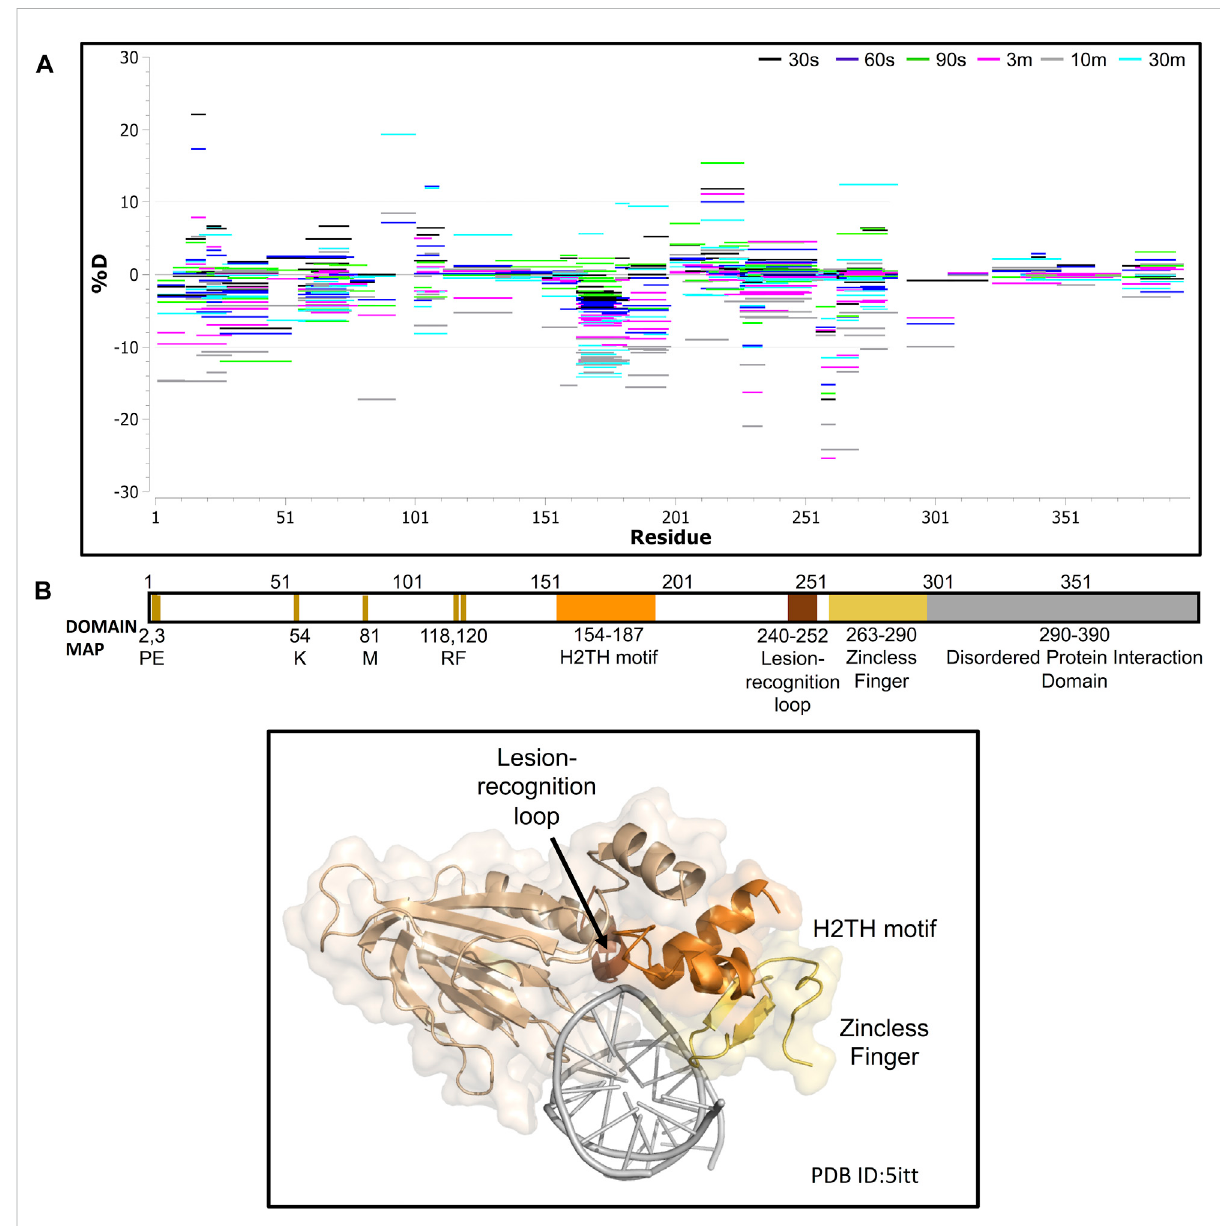
FIGURE 6 Hydrogen-deuterium exchange experiments for the NEIL1-DNA complex reveals regions of NEIL1 involved with DNA binding. (A) Woods plot representing the distribution of NEIL1 regions displaying differential levels of solvent protection in the presence of DNA. Percent change in deuteration for peptides after various time points (30 s – 30 m) between NEIL1 and the NEIL1-DNA complex, where a negative percentage indicates less deuteration and more protection as a result of complex formation between NEIL1 and the DNA. Each horizontal line in the plot represents an individual peptide with residue range on the X-axis and deuteration level i.e., level of protection on the Y -axis. (B) Domain map and cartoon representation of crystal structure of NEIL1-DNA complex (PDB ID:5itt) are displayed. The active site and void- fi lling residues, and DNA binding motifs are indicated in the domain map. In the structure, the DNA is colored grey, and each region is color-matched to the domain map